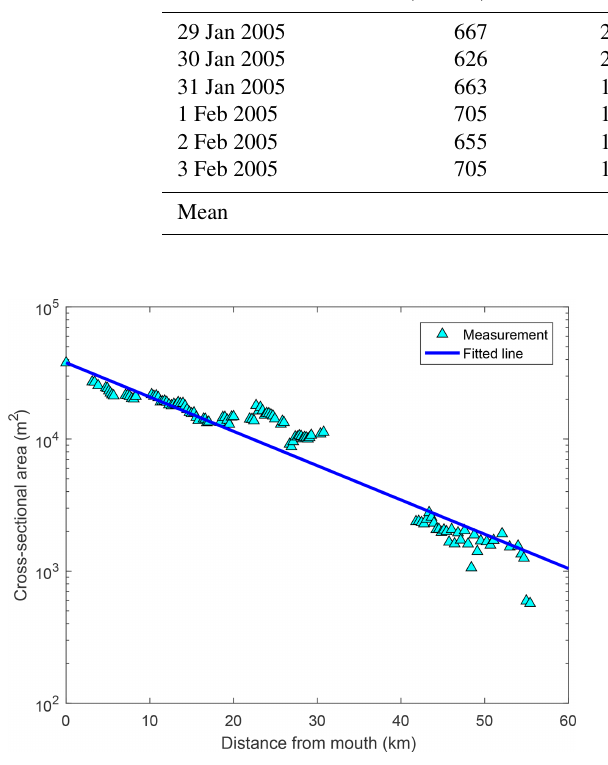
Figure 3. Relative salinity concentration along the Humen estuary. The circlers represent observations, and the lines represent the fit to Eq. (12). s is the salinity at distance x from the estuary mouth, s 0 is the salinity at the mouth, and a is the convergence length of the cross-sectional